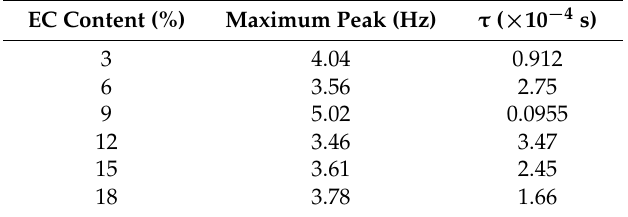
Figure 9. Variation of tan σ with log frequency at different percentage of EC plasticizer. Table 2. Relaxation parameter for different ratio percentage of EC plasticizer.